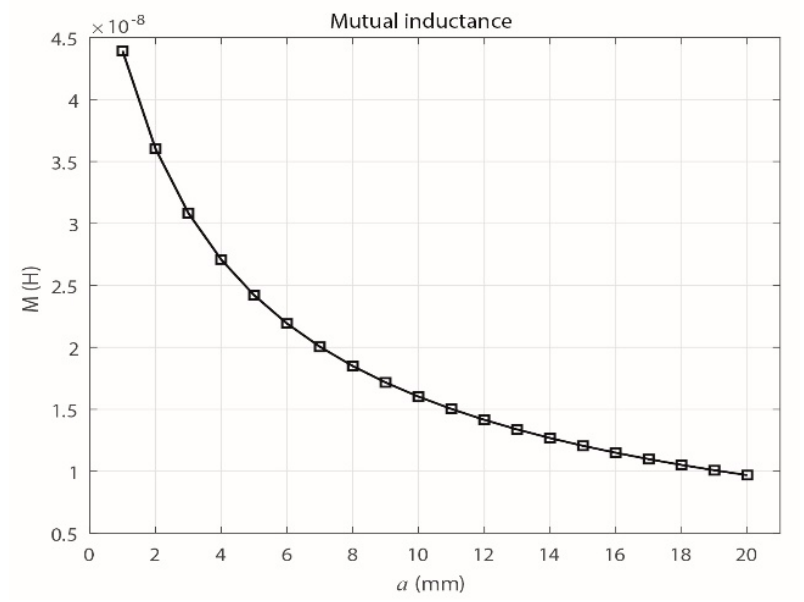
Figure 4. Theoretical behavior of the mutual inductance with increasing a .